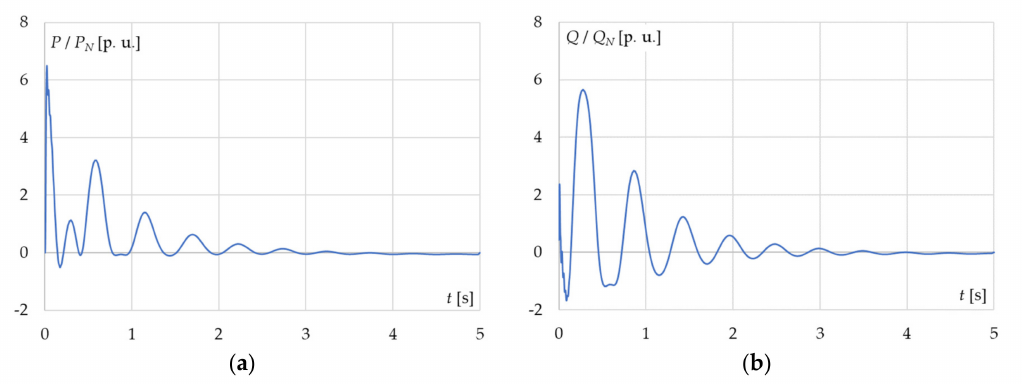
Figure 21. Waveforms of active ( a ) and reactive power ( b ) during out-of-phase synchronization of − 120 ◦ . Figures 22–24 present the flux lines, current densities in rotor bars, and flux densities in cores, respectively, for selected time steps. For a time instant of 0.02 s, physical phenomena were shown just before the simulated faulty synchronization. The flux lines presented the symmetrical poles, where the saturation in cores were within the limits (in the stator core below 1.9 T; in the rotor core below 1.5 T) and currents flowing through the rotor bars were very small and did not exceed 65 × 10 4 A / m 2 (the maximum value of current in the bar was below 130 A).